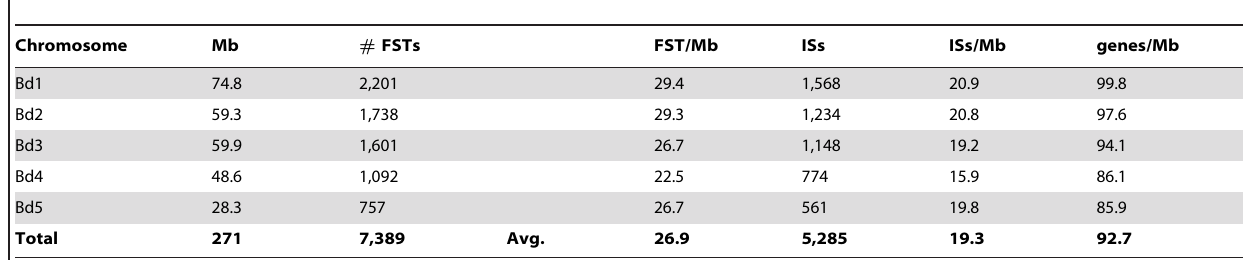
Table 7. Chromosome distribution of FSTs, ISs, and genes.